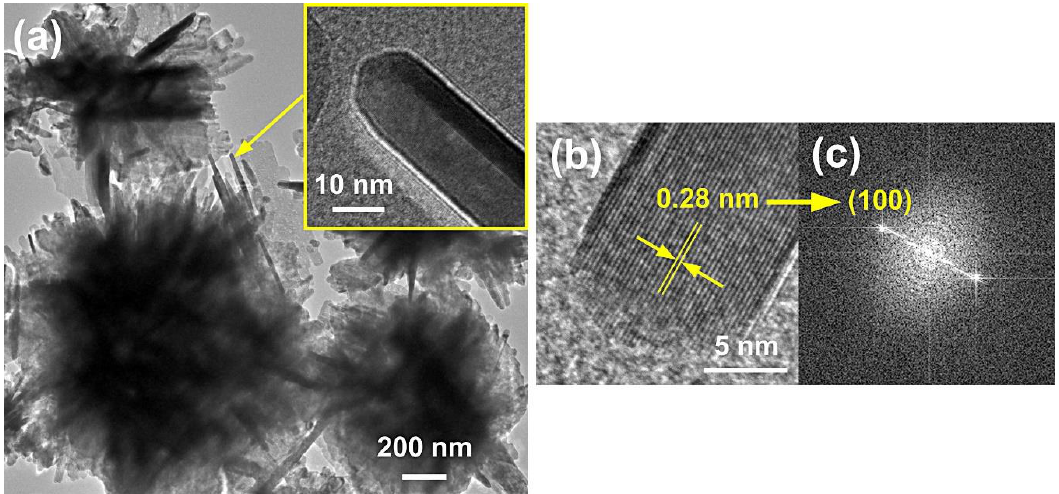
Figure 53. TEM micrographs of ( a ) as-prepared ZnO nanoparticles, ( b ) HRTEM micrograph showing the lattice fringes in the ZnO nano-crystal with its SAED (selected area electron di ff raction) pattern as